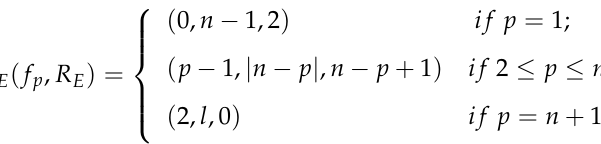
Figure 2. The line graph of a necklace graph: L ( N e